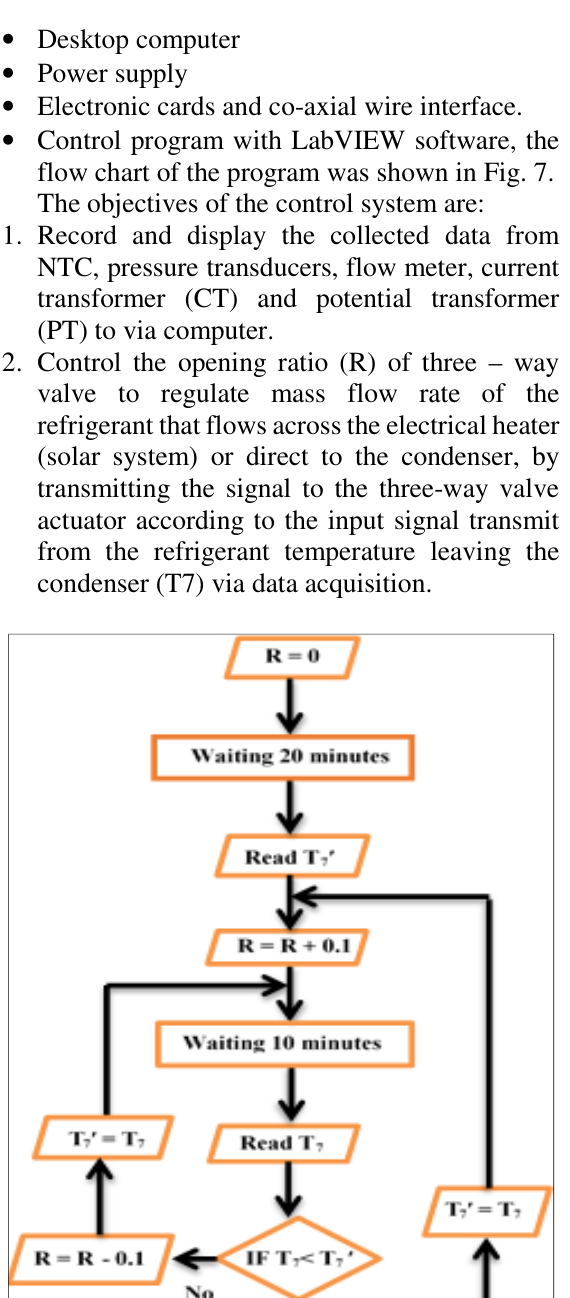
In the automatic mode for the opening valve ratio (R), the control program regulates the ratio of mass flow equation of the refrigerant as a function of refrigerant temperature leaving the condenser (T7), where the opening ratio is set in position to achieve minimum refrigerant temperature leaving the condenser (subcooled) to increase the COP of the system. Fig. 8 represents the national instrument data